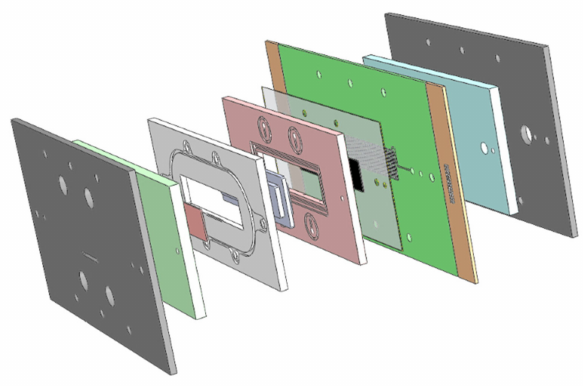
Figure 2. Exploded view of the H 2 -Br 2 cell with PCB on the